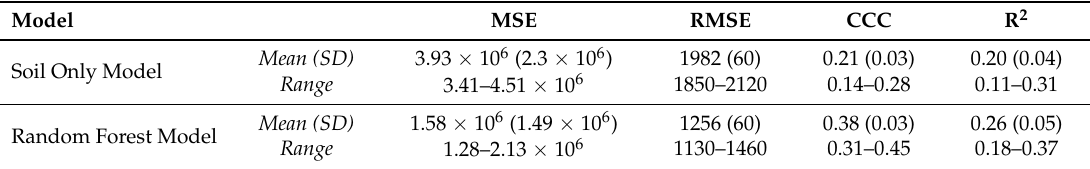
Table 3. Model performance measures for soil-only and random forest